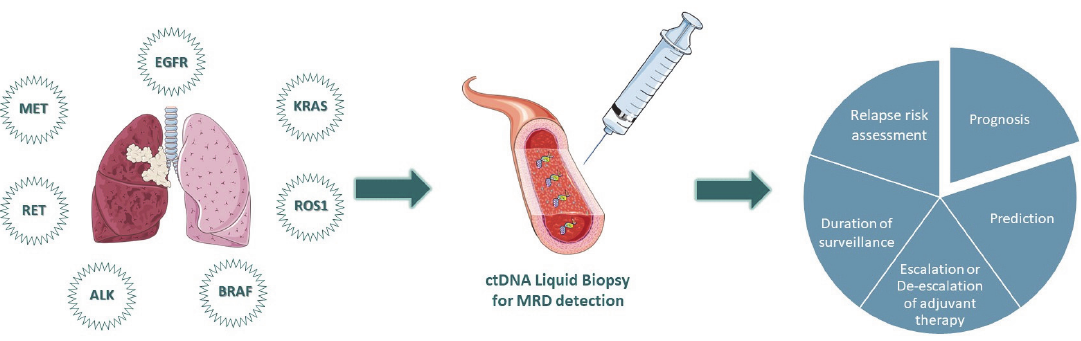
Figure 1. Rationale of personalized ctDNA-based detection of minimal residual disease in patients with oncogenic-driven NSCLC.